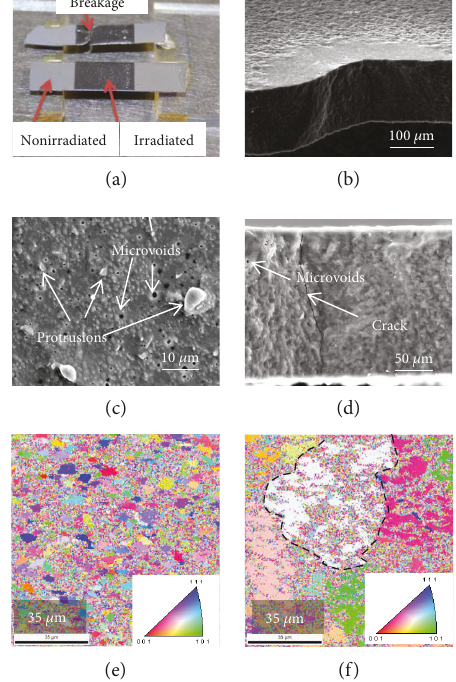
Figure 1: (a) Photograph of the samples irradiated by the laser at 15.0 (upper case) and 13.5kW cm − 2 (lower case) at a scan speed of 10mm s − 1 ; (b) SEM image (70 ° tiled) at the cross section with a rough surface of the nonirradiated region and the smooth laser-recrystallized region; (c) surface morphology of the laser-recrystallized region showing examples of protrusions and microvoids on the surface; (d) a crack induced by the laser recrystallization process and microvoid in the volume; (e) top- view EBSD image of the as-cut pc-Si sample; (f) top-view EBSD image of the laser-recrystallized (at a power density of 13.5kW cm − 2 ) pc-Si sample.